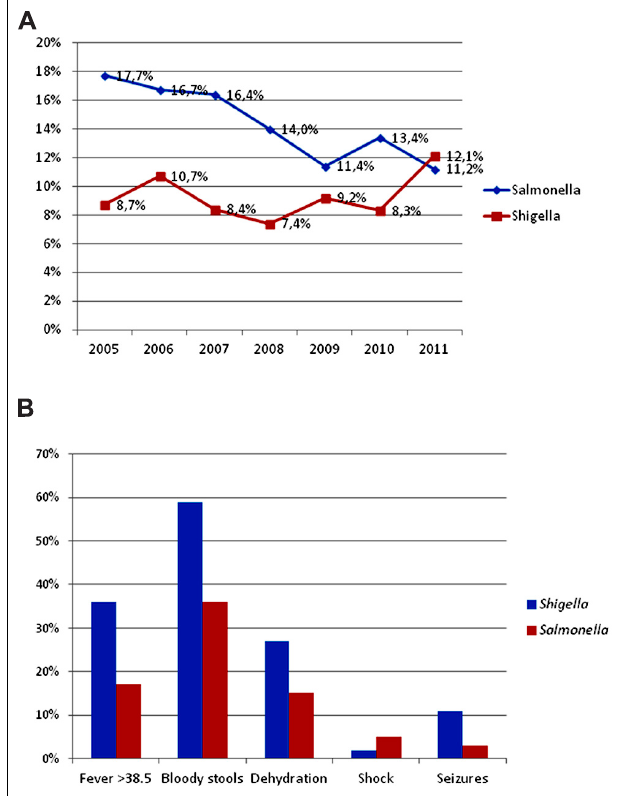
FIGURE 1 | Frequency and clinical presentation of Salmonella and Shigella infections in ill children at a state referral hospital inYucatan, Mexico, 2005–2011. (A) There was a statistically significant trend toward decreasing Salmonella gastroenteritis, from 17.7% in 2005 to 11.2% in 2011 ( p < 0.001). In contrast, there was a precipitous increase in shigellosis from 8.3% in 2010 to 12.1% in 2011. (B) Children with Shigella had twice as much fever ≥ 38.5 ◦ C, bloody stools, dehydration, and almost four times as many seizures, compared to those with Salmonella . Children with salmonellosis, however, were more likely to be admitted with hypovolemic shock.